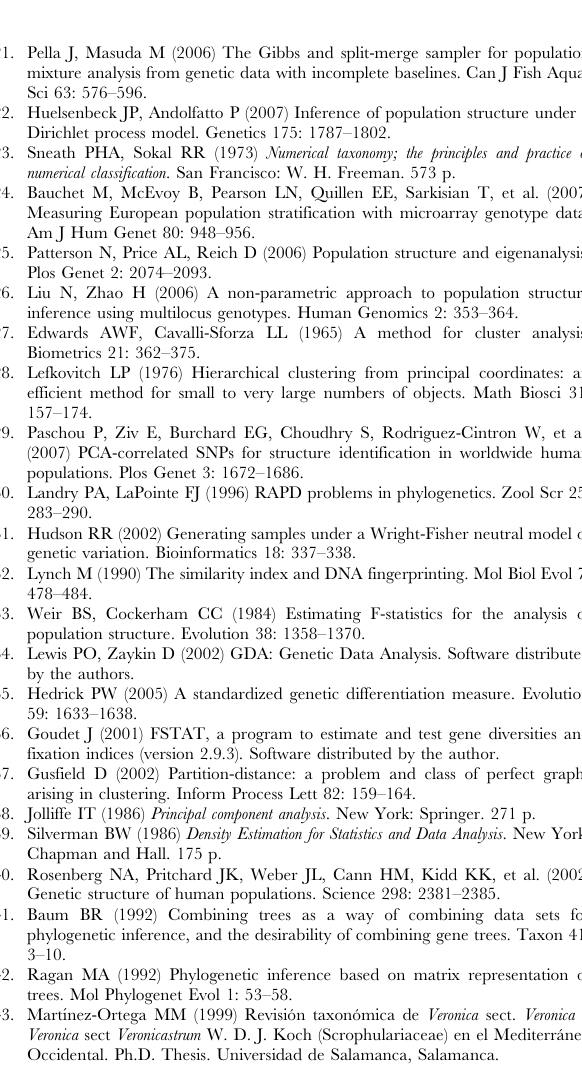
Figure S1 Exponential regression of two support metrics (p- value and stability) on cluster size for 27 real data sets. Grey points indicate observed support values; triangles indicate median support values calculated when three or more clusters of a particular size were found. Regressions were performed using median values. A) P-value is strongly associated with cluster size. Dotted line indicates a p-value of 0.05. Twenty or more individuals per subpopulation should be sampled in order to achieve p , 0.05. B) Stability value is weakly associated with cluster size. In general, smaller subpopulations can be inferred by using a stability based cutoff instead of a significance based cutoff.